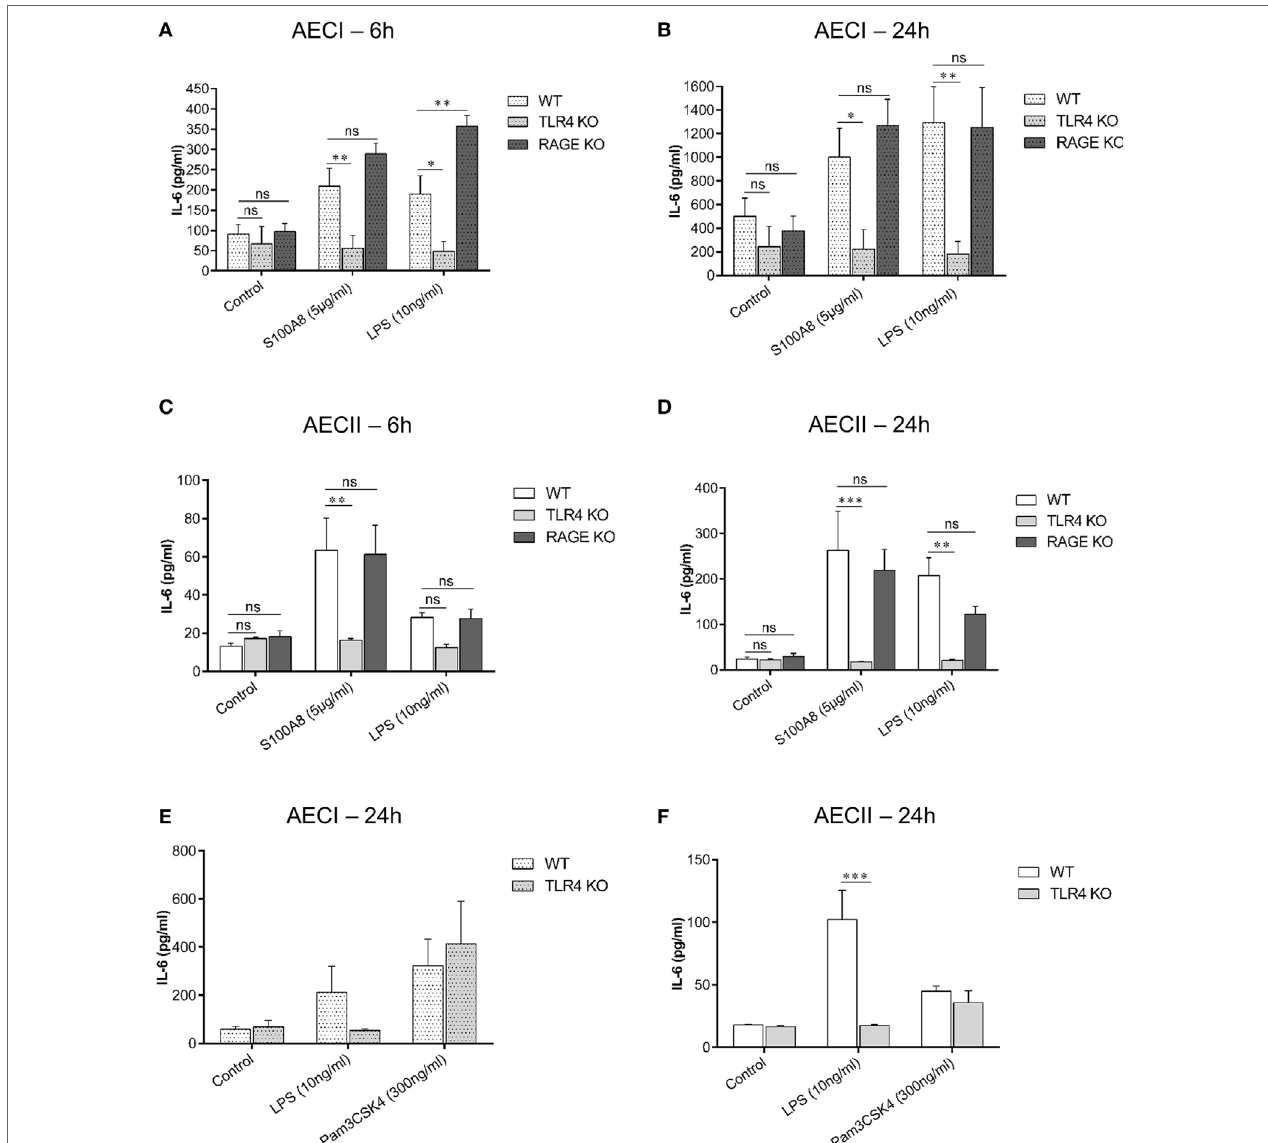
FigUre 5 | TLR4 signaling pathway is involved in IL-6 release from alveolar epithelial cells (AECs). AECI (a,B) and AECII (c,D) from WT, TLR4 knock out (TLR4 KO), and RAGE knock out (RAGE KO) mice were stimulated with murine S100A8 (5 µg ml − 1 ) or lipopolysaccharide (LPS) (10 ng ml − 1 ) for (a,c) 6 h and (B,D) 24 h. IL-6 levels were analyzed by enzyme linked immunosorbent assay (ELISA). Data are expressed as mean ± SEM ( n = 3 experiments). * p < 0.05, ** p < 0.01, *** p < 0.001, ns, not significant, compared to WT AECs. Confluent monolayers of (e) AECI or (F) AECII from WT and TLR4 KO mice were stimulated with TLR agonists, LPS or Pam3CSK4 for 24 h and IL-6 levels were analyzed by ELISA. Data are expressed as mean ± SEM [ n = 3 experiments for AECI (e) , n = 4 experiments for AECII (F) ]. *** p < 0.001, compared to WT